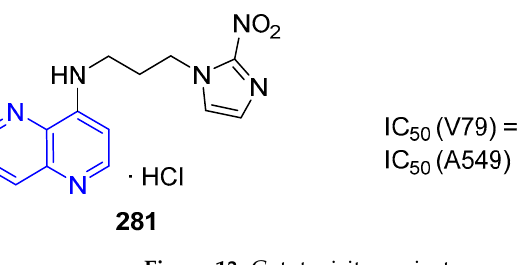
Figure 12. Inhibition of topoisomerase I activity.